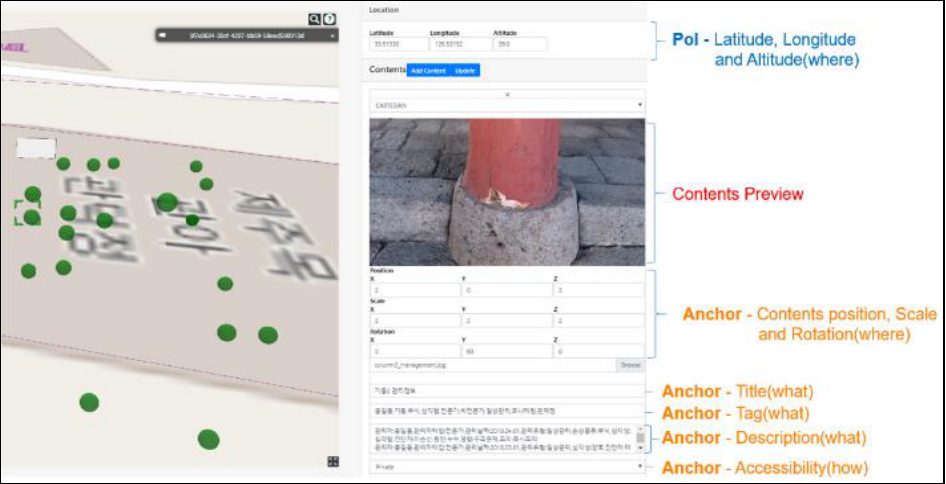
Figure 7. A geo-tagged content authoring tool.